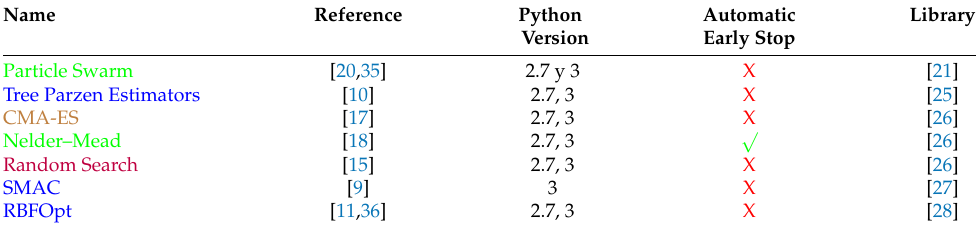
Table 4. HPO algorithms used. Colors explanation: Bayesian methods in blue, decision-theoretic techniques in pink, evolutionary algorithms in brown, and other optimization algorithms in green.